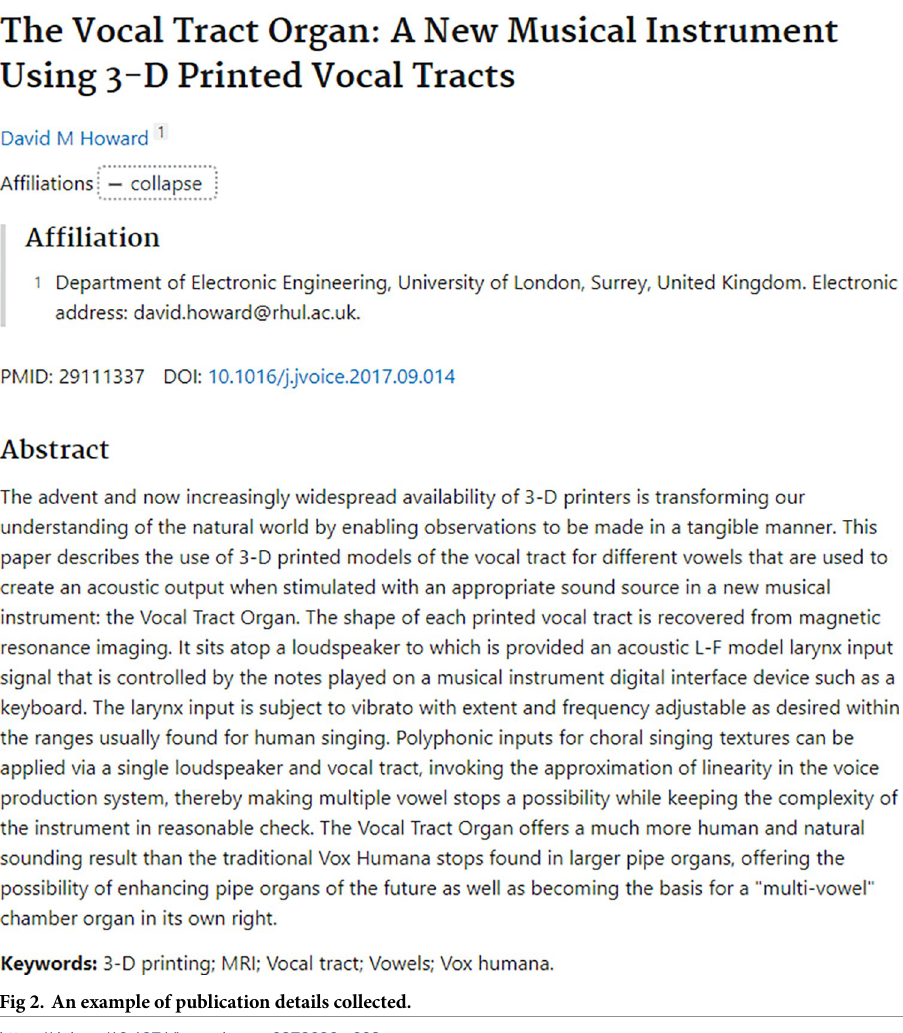
Fig 2. An example of publication details